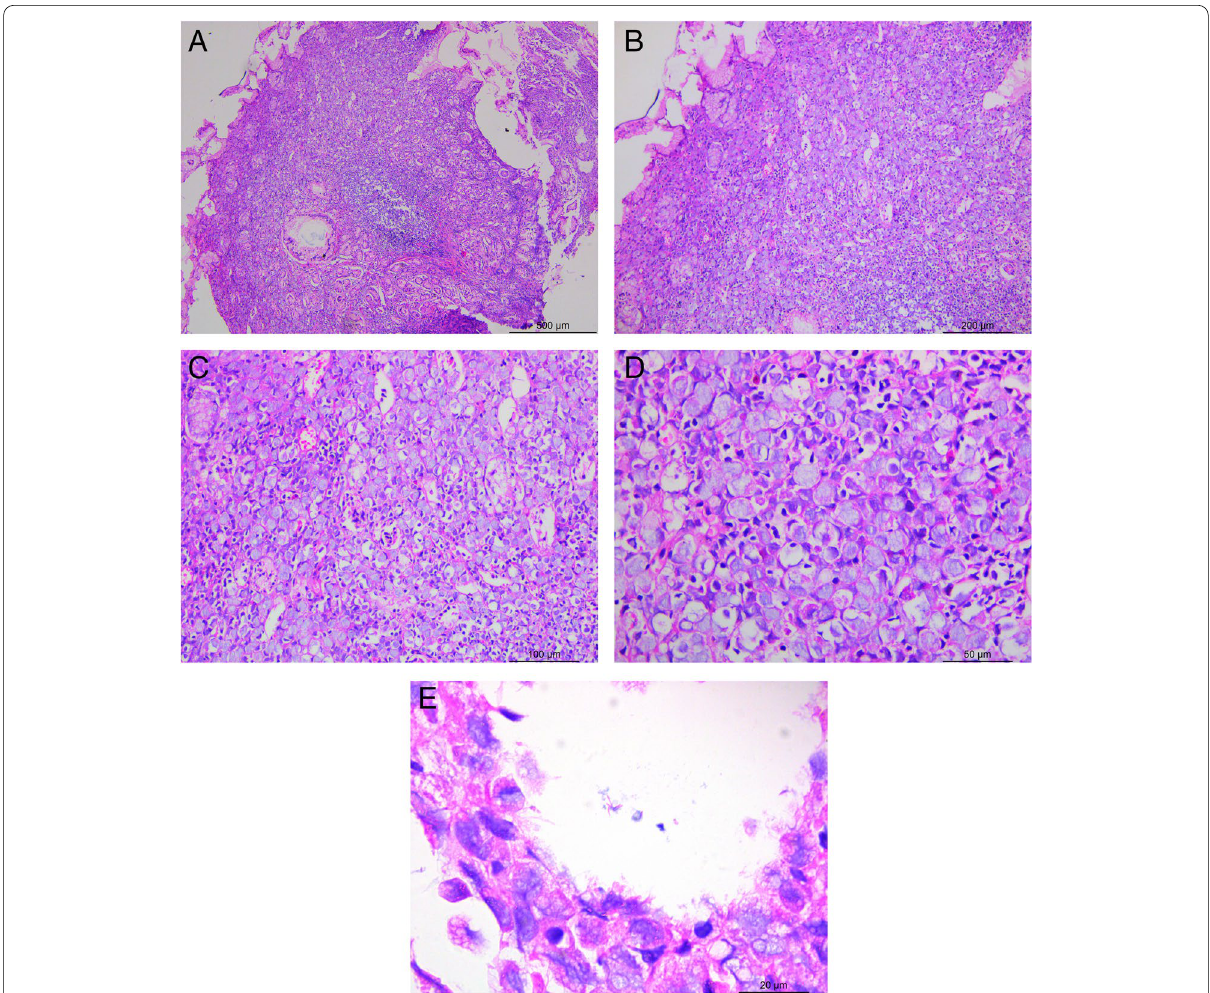
Fig. 2 Microscopically, a large number of cytoplasm-rich, nucleus-deviating, ring-like cells, 5–13 μm in diameter, with basophilic mucus-like material in the cytoplasm, are seen between the glands of the lamina propria, and the cells are distributed in foci or sheets, like grapes ( A :H&E stain 50, B :H&E 100, C : H&E stain 200, D :H&E stain 400). Several short, thin rods of H. pylori were seen in the gastric mucosal space( E : H&E × × × ×